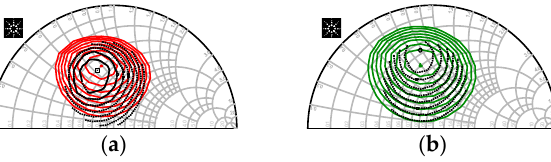
Figure 12. Comparison between simulated impedance chart and measured one: ( a ) maximum Pout and ( b ) maximum power added efficiency (PAE).